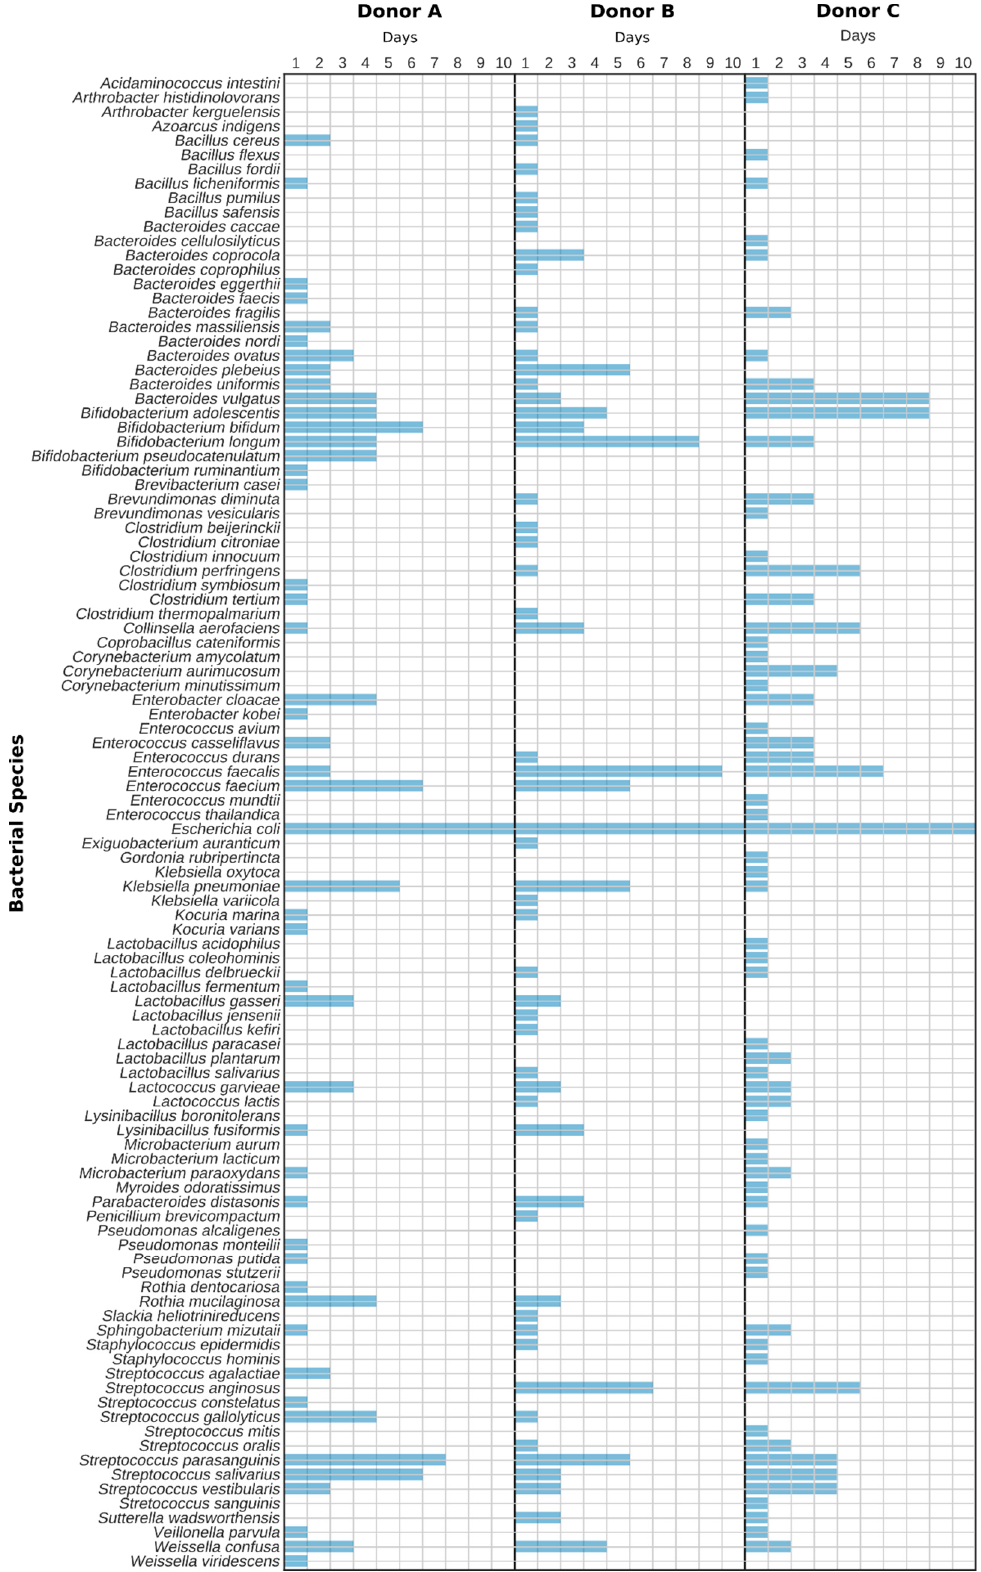
Figure 4. Diagram showing the daily presence of the particular cultivable bacterial species in stool samples.